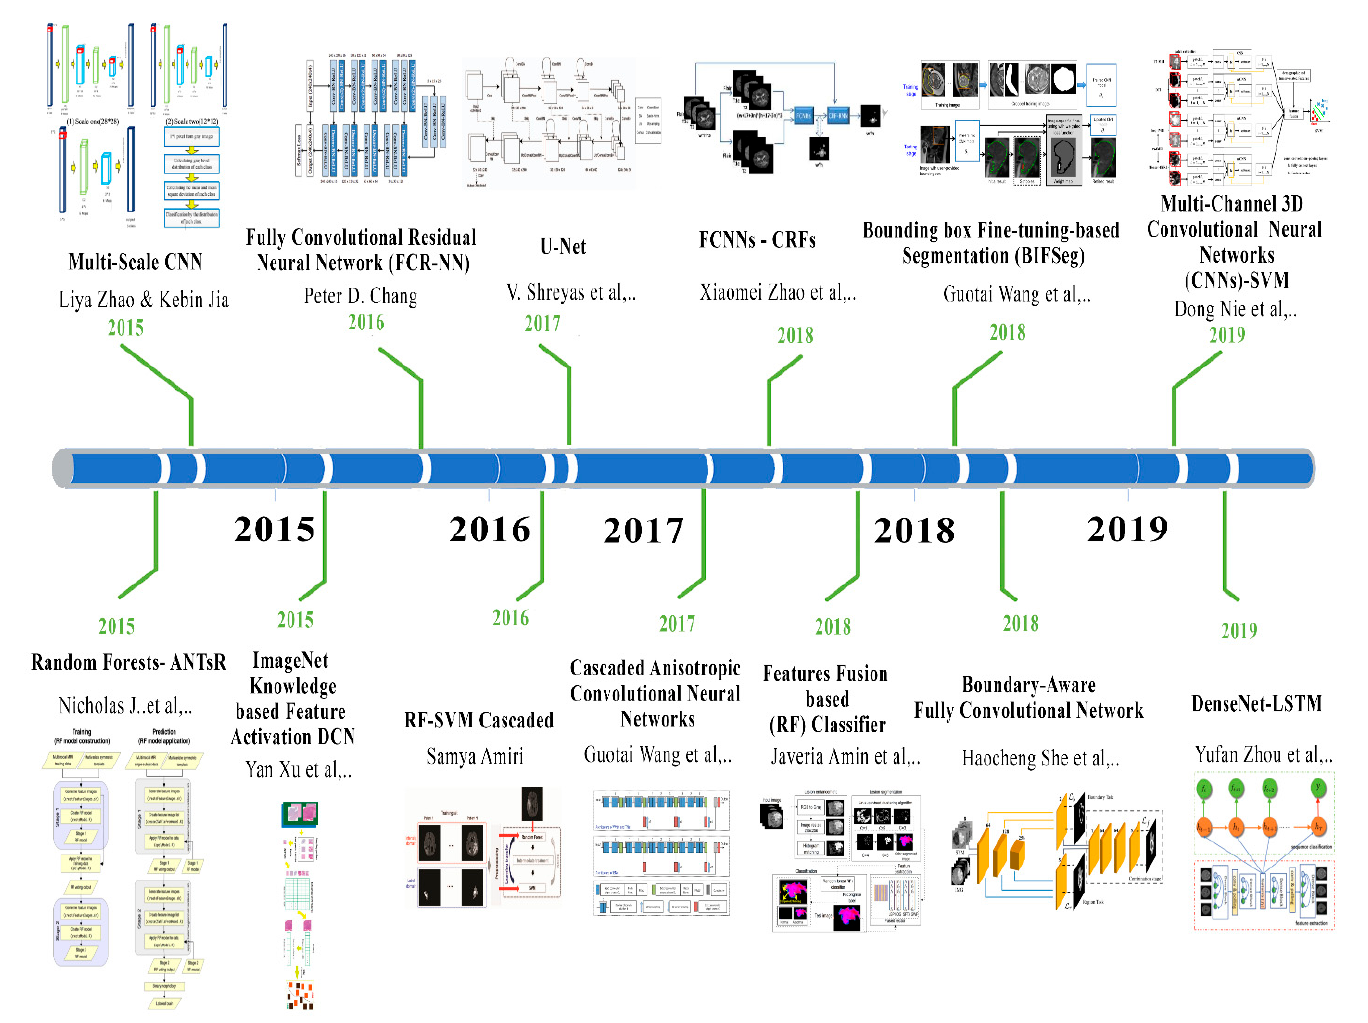
Figure 4. Deep learning development toward brain tumor through recent years.